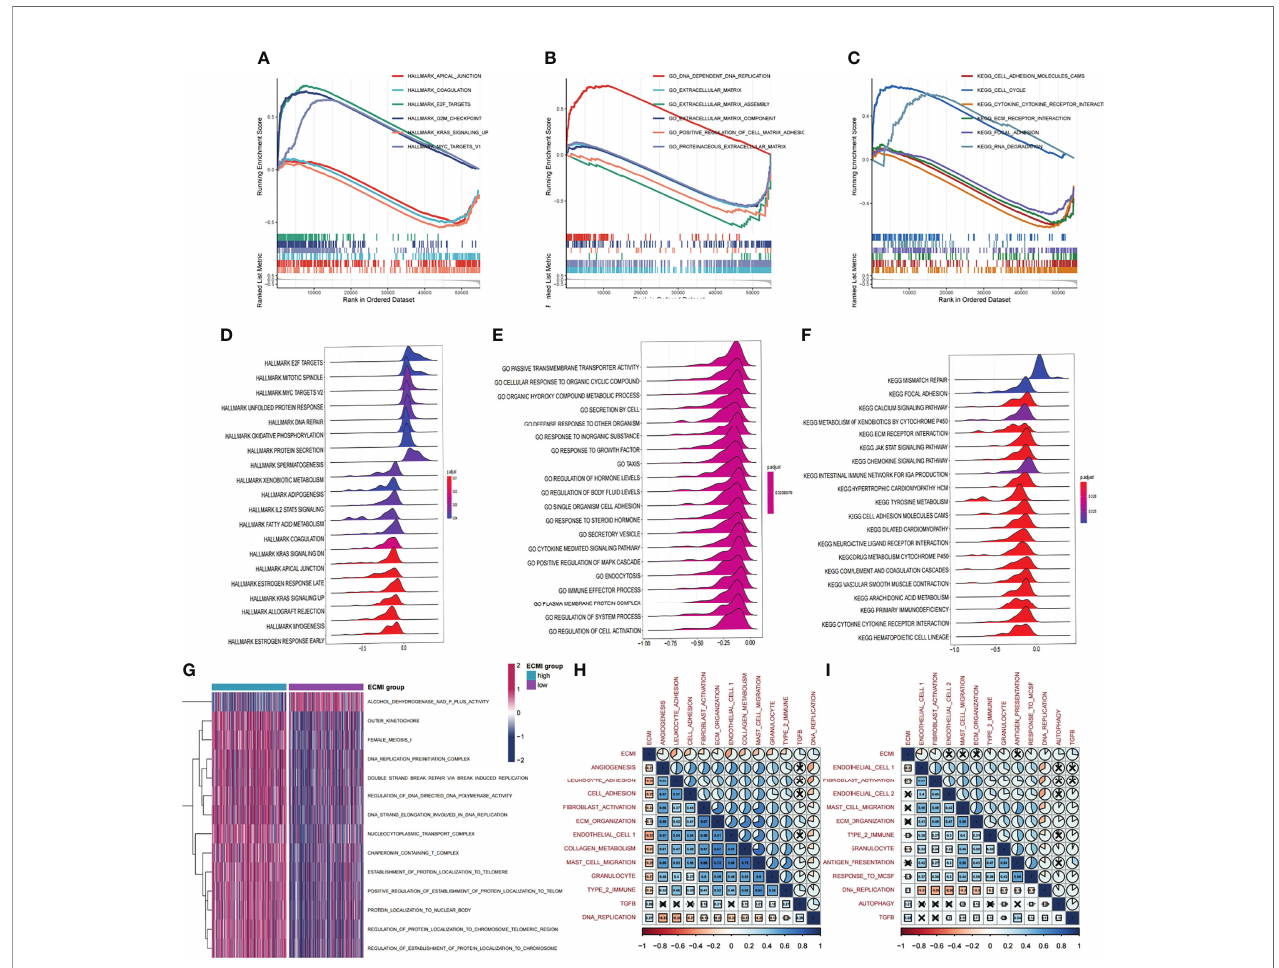
FIGURE 4 | Biological value of the ECMI. (A – C) GSEA running plot showing the biological process of Hallmark, GO, and KEGG enriched in ECM high and low. (D – F) Ridge plots showing the top enriched biological process of GO, KEGG, and Hallmark in TCGA. (G) GSVA exhibiting the different expressed gene sets between the two groups. (H, I) The correlation between biological process and the ECMI in both TCGA and Metabric cohorts (the row annotation and column annotation are the abbreviation of the gene